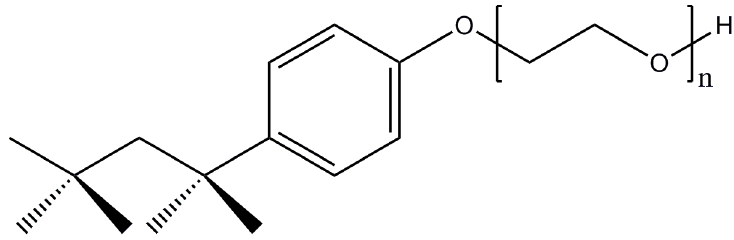
Figure 11. Structure of Triton X-100 (chemical formula is C 14 H 22 O(C 2 H 4 O)n where n = 9, 10).